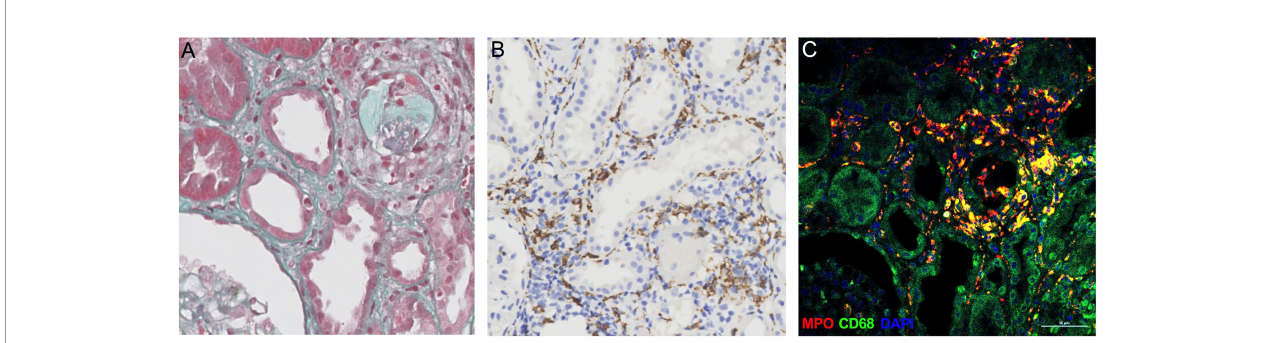
FIGURE 5 | Myeloperoxidase (MPO)-containing macrophages in allograft biopsy of kidney transplant recipients. (A) Representative examples of Masson ’ s trichrome staining image of allograft biopsy. (B) Immunochemistry staining with anti-CD68 antibodies for macrophages in allograft biopsy. (C) Immuno fl uorescence images to show colocalization of MPO+ (in red) with macrophages (CD68+, in green). Scale bar: 50 m m.